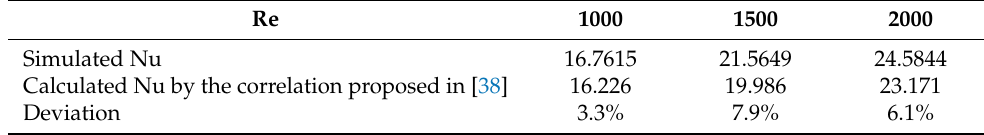
Table 3. Validation